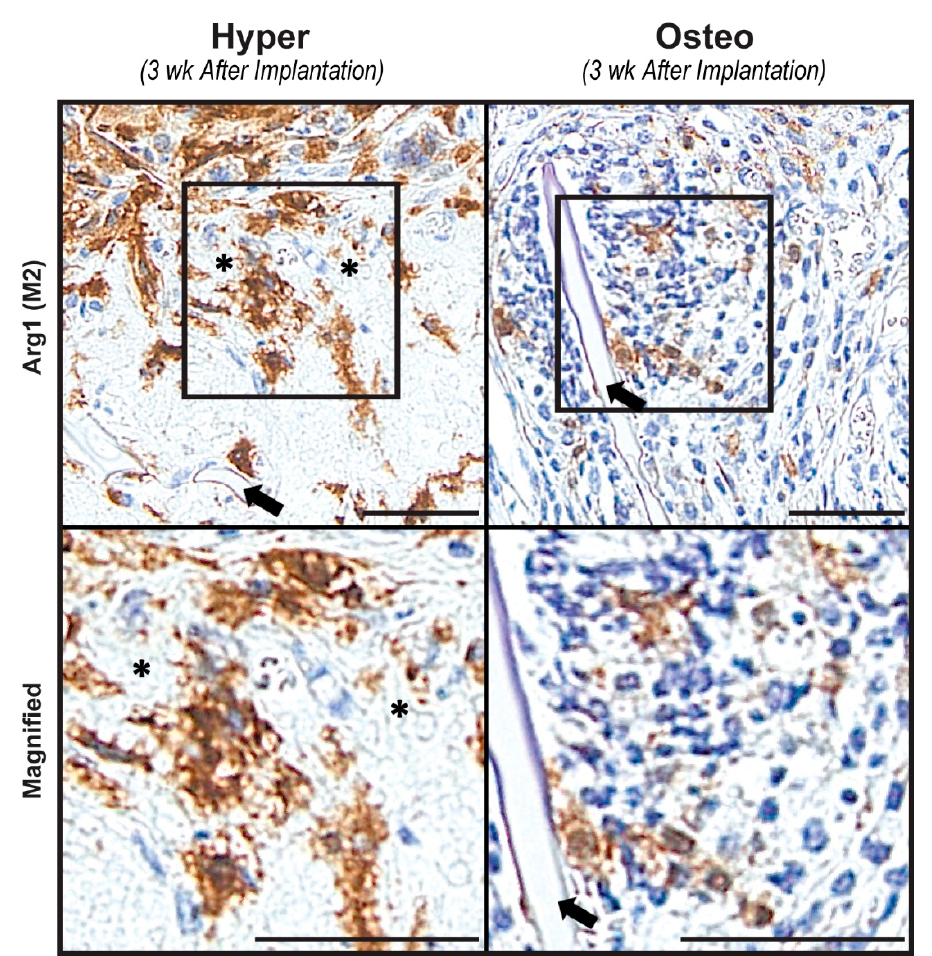
Figure 5. Presence of macrophages. Arg1 immunohistochemistry staining was conducted to evaluate the presence of M2 macrophages in the constructs after 3 weeks of implantation. Representative images demonstrate numerous M2 macrophages, as indicated by the brown staining localized around the matrix resembling calcified cartilage (the white, round matrix marked by black asterisks) in the hyper constructs. In the osteo constructs, fewer M2 macrophages were found to be localized in proximity to the scaffold (the silk scaffold is indicated by black arrows in both constructs). Scale bars: 50 µm.